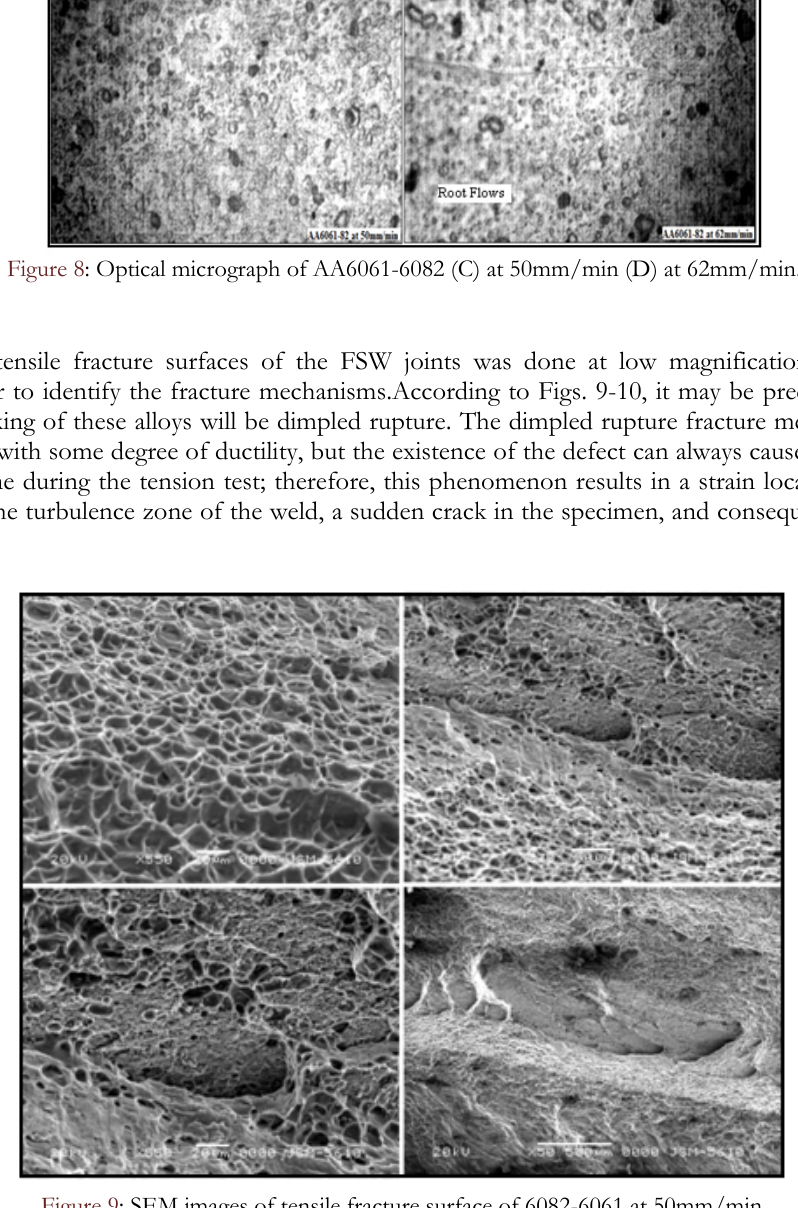
Figure 9: SEM images of tensile fracture surface of 6082-6061 at